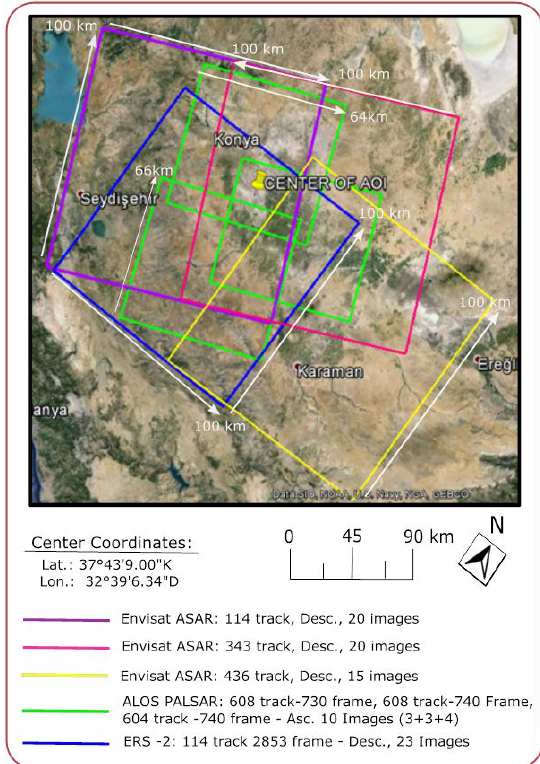
Figure 2. Envisat ASAR, ALOS PALSAR and ERS-2 SAR image frames on the Google Earth view